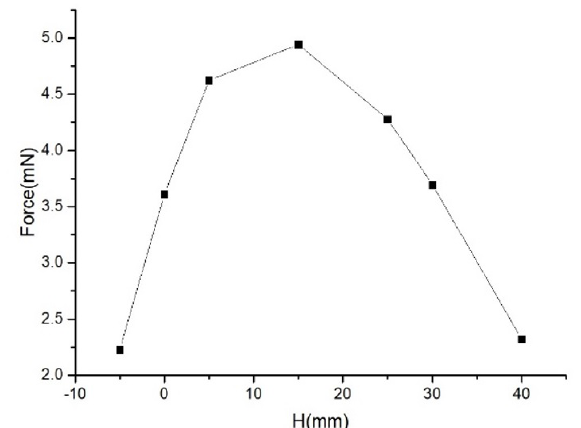
Fig. 10. Influence of the relative position of the shaft core and the coil on the stress of the shaft core.